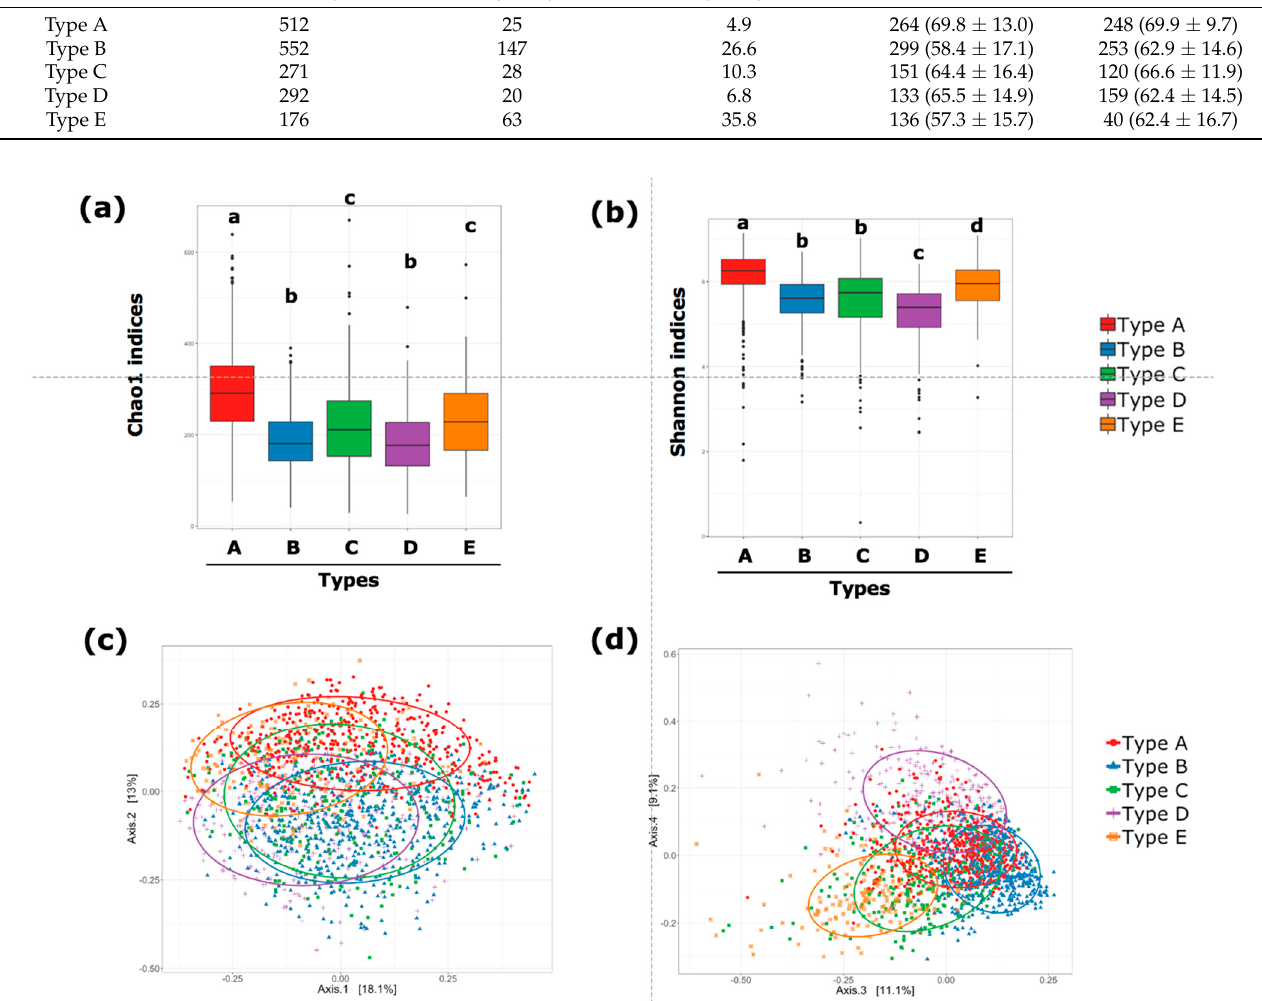
Figure 2. α -diversity and β -diversity of gut microbiota for five PAM-identified communities. α - diversity assessed by Chao 1 index (ASV richness estimation) ( a ) and Shannon index (ASV evenness estimation) ( b ). Statistical differences in α -diversity indices among the groups were evaluated using one-way ANOVA. Statistical significance ( p < 0.05) is indicated by different letters. β -diversity represented by principal coordinate analysis plots based on Bray–Curtis dissimilarity. Axis 1 and axis 2 ( c ) and axis 3 and axis 4 ( d ). Ellipses enclosing the clusters indicate an 80% confidence interval. Statistically significant differences in β -diversity among the groups were confirmed using PERMANOVA ( p = 0.001).